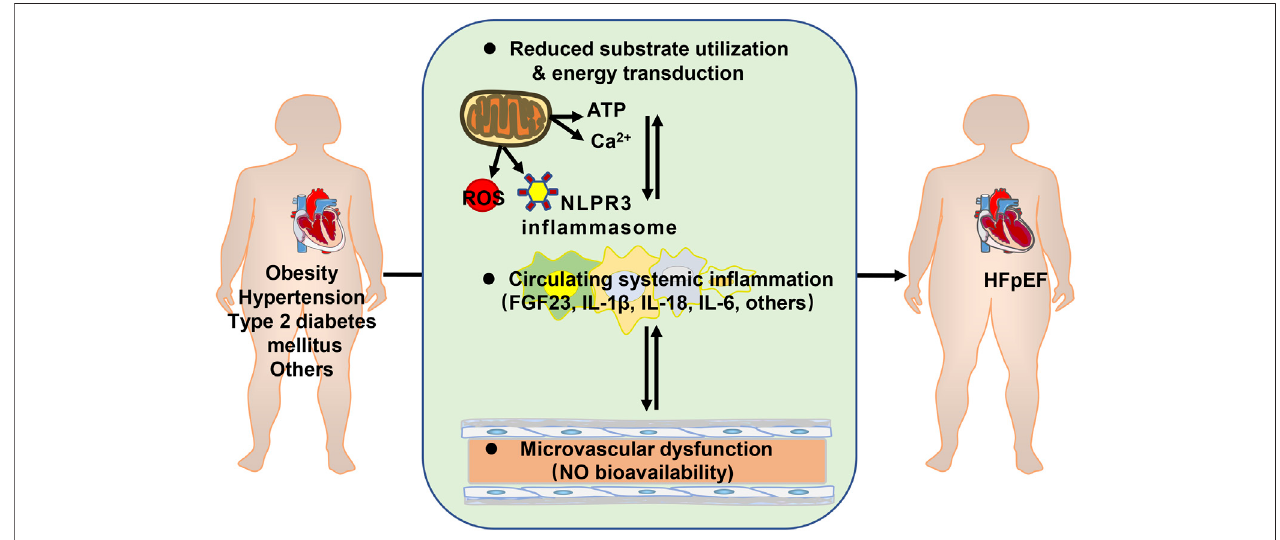
FIGURE1| Metabolicdisorderscontributingtoheartfailurewithpreservedejectionfraction(HFpEF).ATP:adenosinetriphosphate;ROS:reactiveoxygenspecies; FGF23: fi broblast growth factor 23; IL: interleukin; NO: nitric oxide.